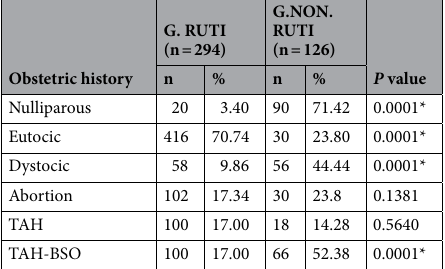
Obstetric history